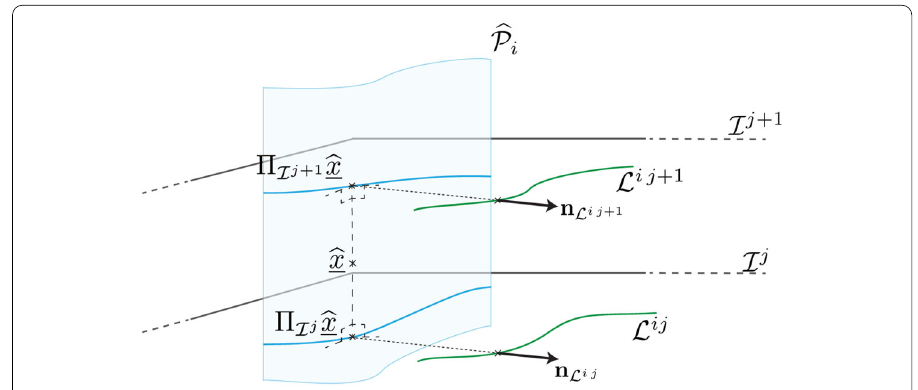
Fig. 4 Illustration of tag grids discrepancy